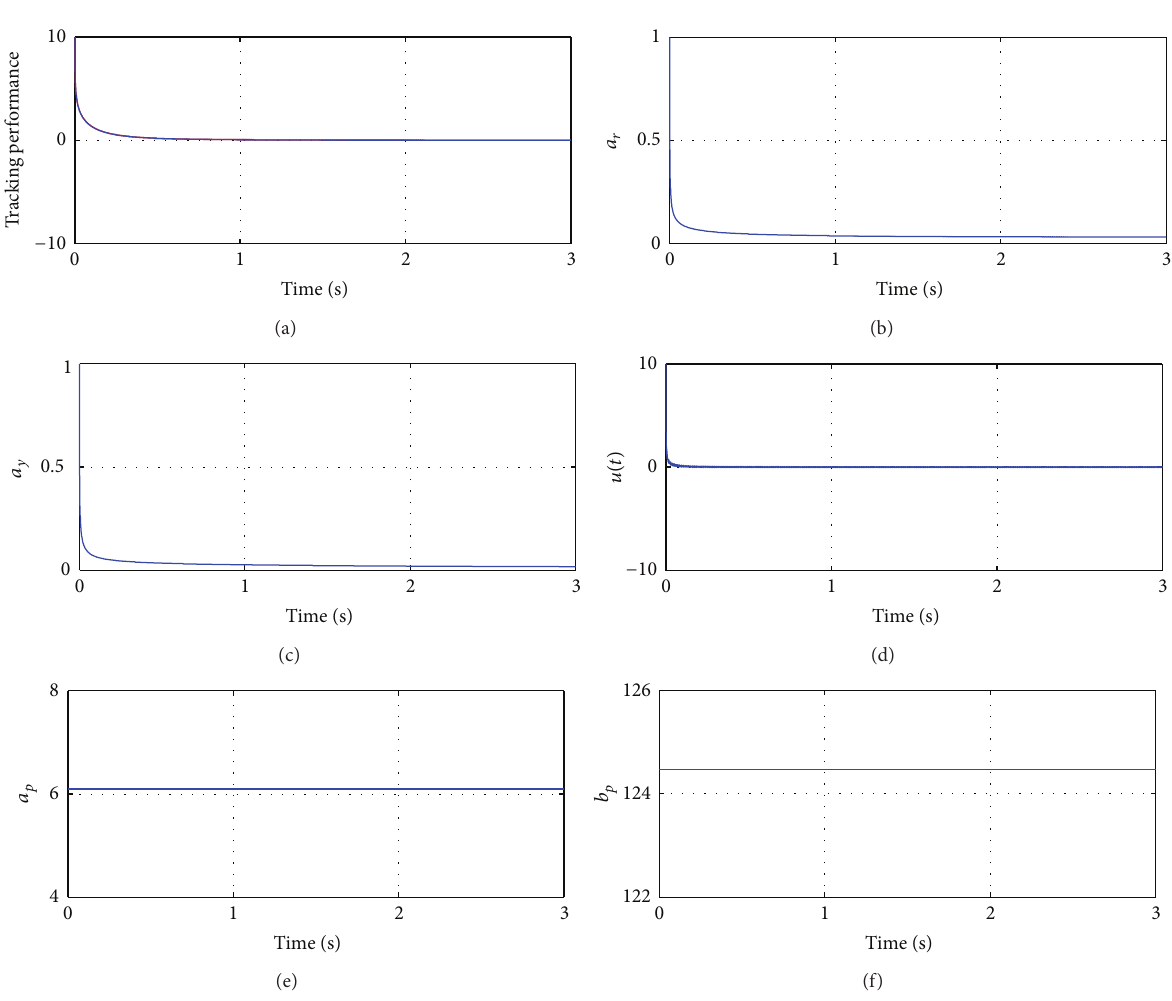
The adaptation gain is chosen to be 𝛾 = 1 , while the fractional orders of the adaptation law are chosen as 𝛼 2 = 0.4 , = 0.4 𝛼 3